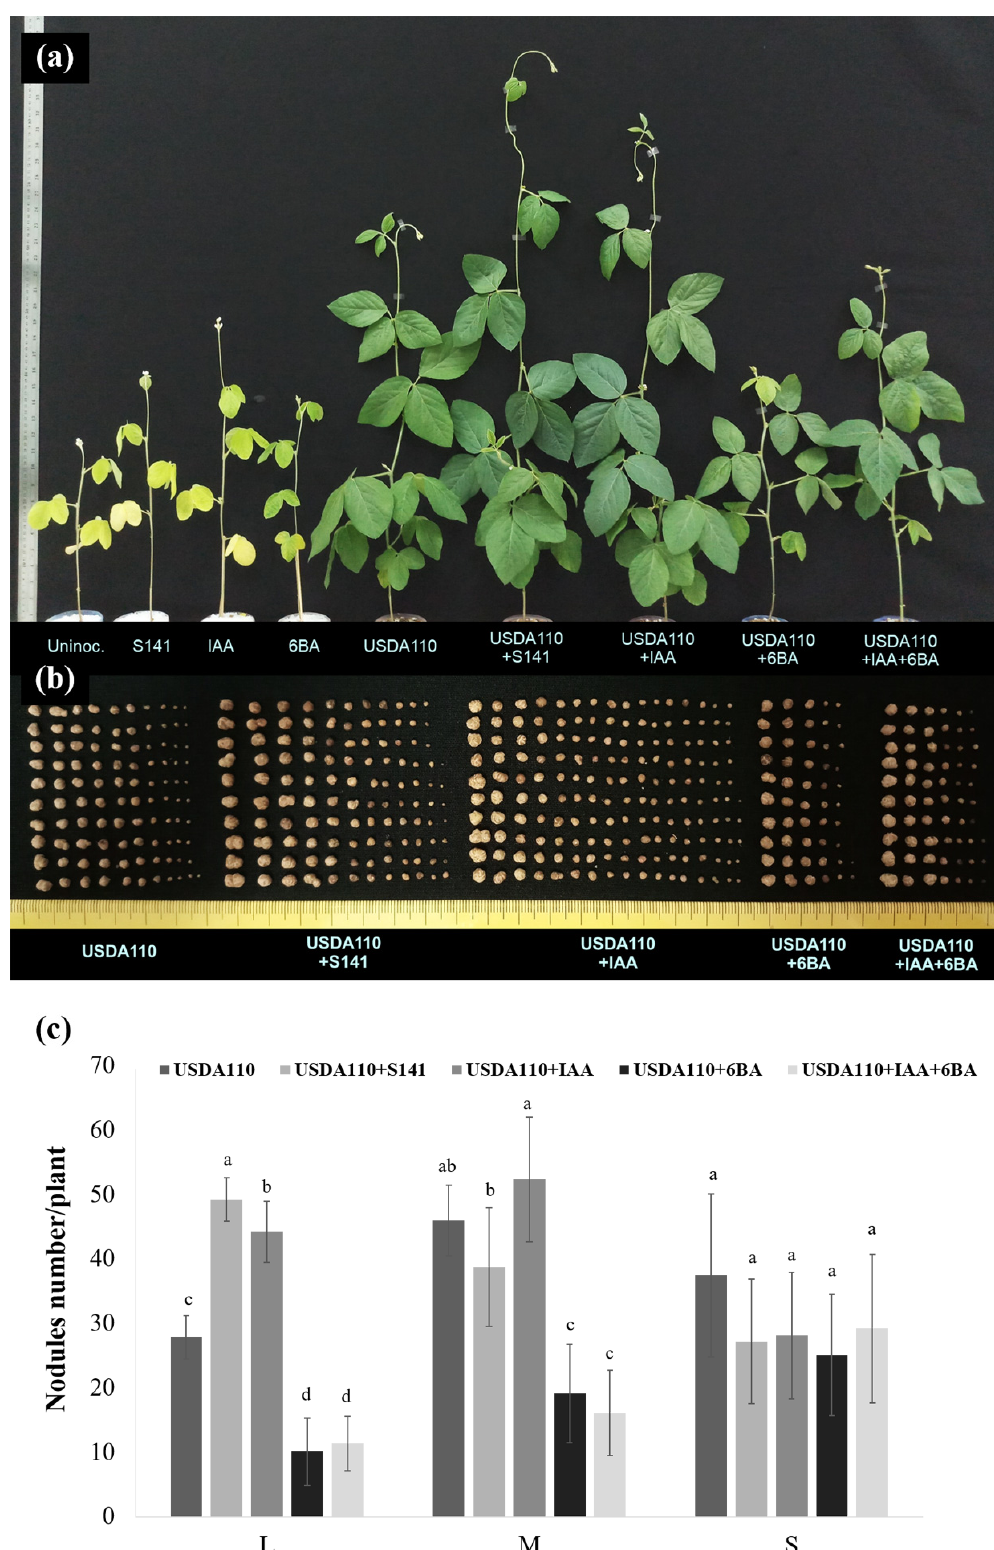
Figure 6. Soybean plant growth and the nodule size separation of soybean cultivar Chiang Mai 60 by co-inoculation with S141 and USDA110 and / or supplemented with IAA and / or 6BA at 45 DAI: ( a ) soybean growth under Leonard’s jar experiments; ( b ) photograph of soybean nodule; and ( c ) nodule size separation. Significance at p ≤ 0.05 is indicated by mean standard error bars (n = 8 ).